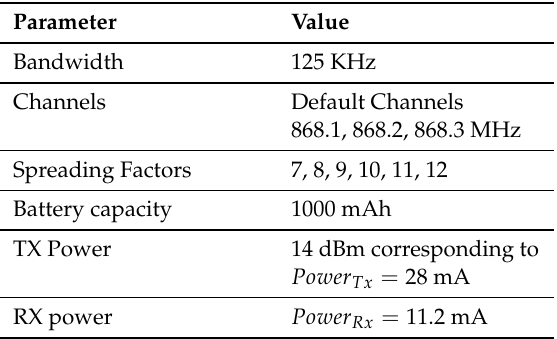
Table 5. Simulation